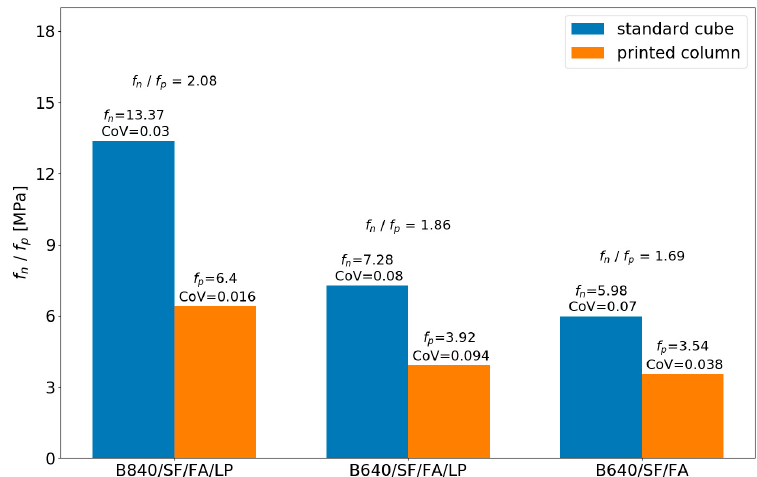
Figure 20. Comparison of compressive strength of printed columns with the results of compressive strength of standard cubes after 10 h.